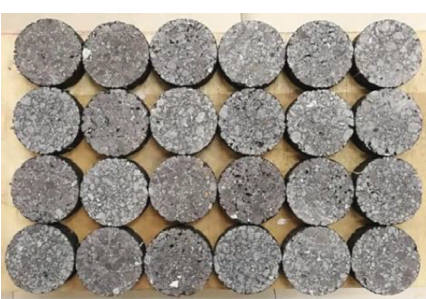
Figure 4: Thermal constant test